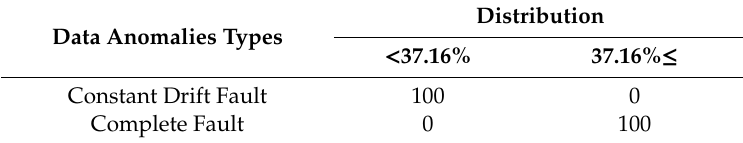
Figure 12. The distribution of the mean-value-crossing rate of constant drift faults and complete faults.